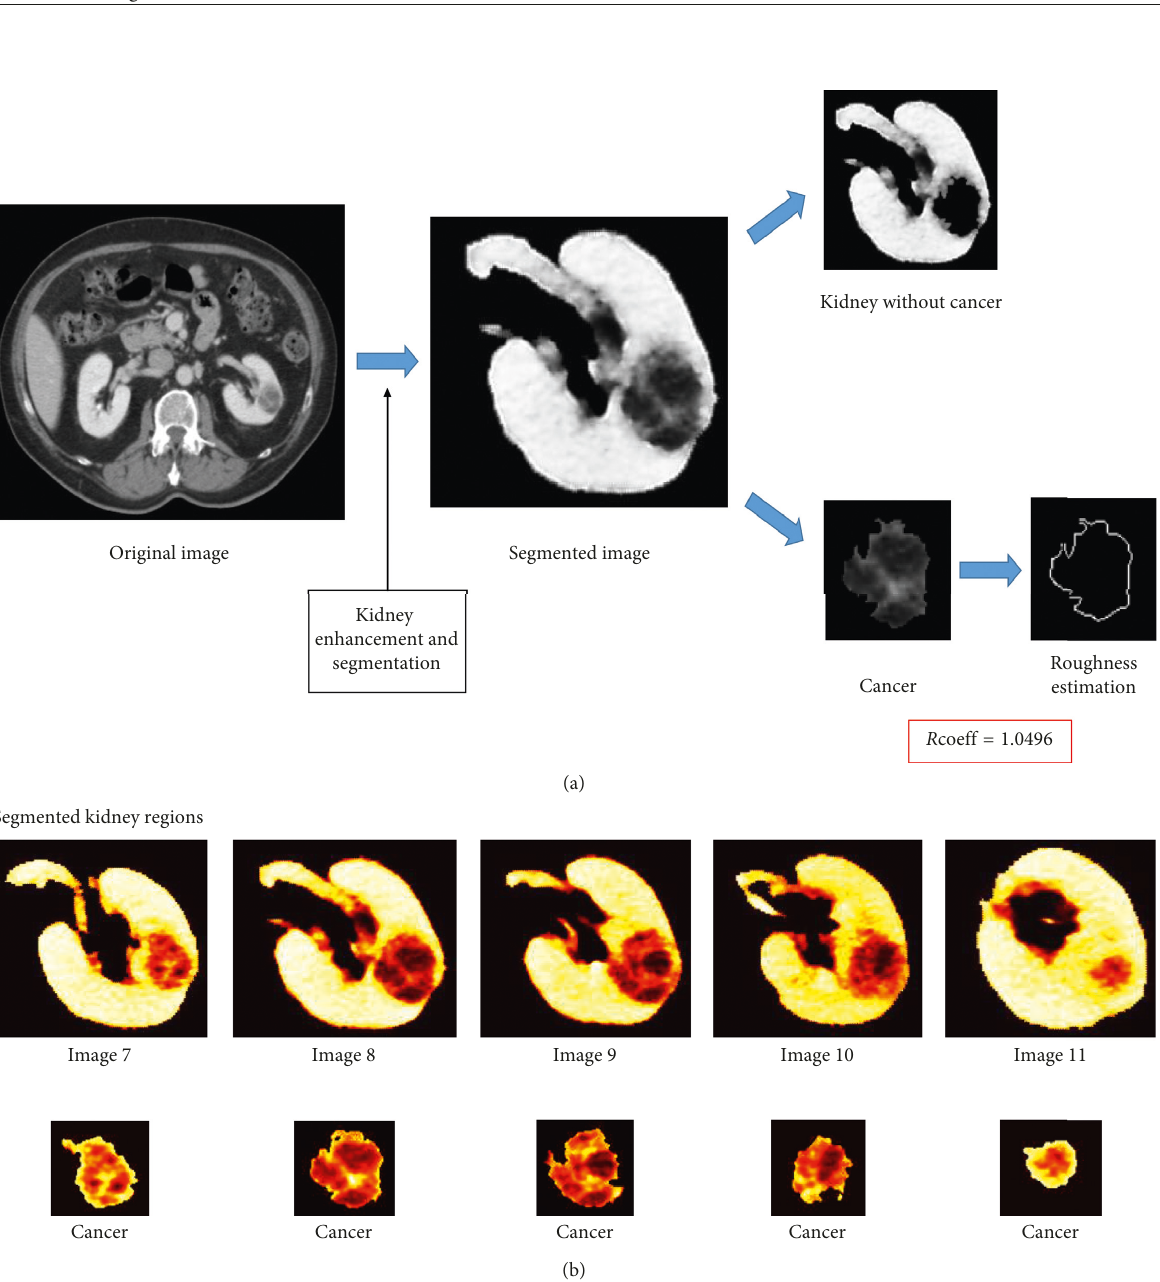
Figure 1: Tumor roughness score image analysis. Adaptive segmentation technique developed to segment the kidney and tumor for surface enhancement and investigate tumor irregularity. The summary irregularity score ( R avg � 1.0413) is averaged across all segments of the tumor.